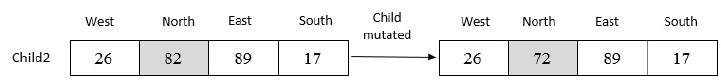
Figure 13. Mutation on second child.